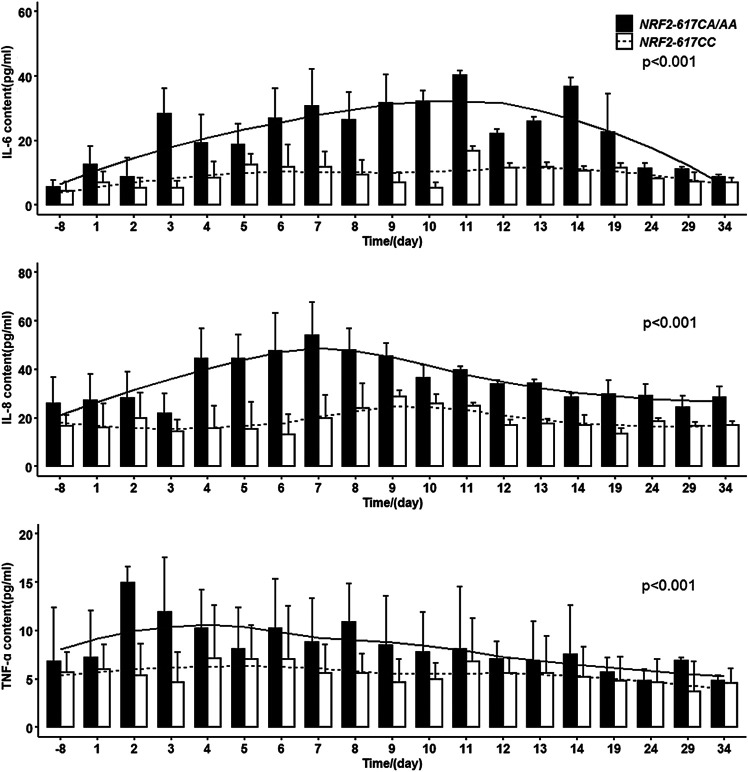
Higher plasma IL-6, IL-8, and TNF-α levels after HSCT in adult patients with NRF2 -617 CA/AA genotypes (n = 37) compared to those with wild genotype (n = 50). Histograms of IL-6, IL-8, and TNF-α levels in the patients with NRF2 -617 CA/AA genotypes and NRF2 -617 CC genotype. Solid and dotted curves represent the locally weighted scatter plot smoothing curves.